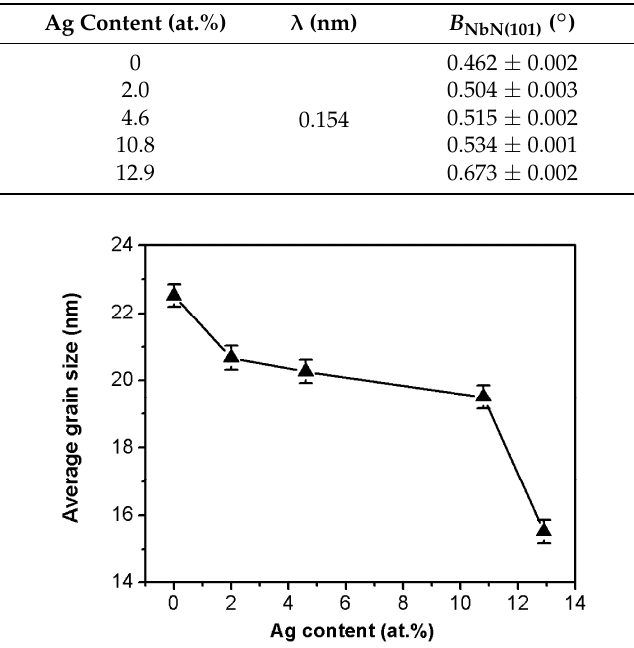
Figure 3. Grain sizes of NbCN phase with different content of Ag.